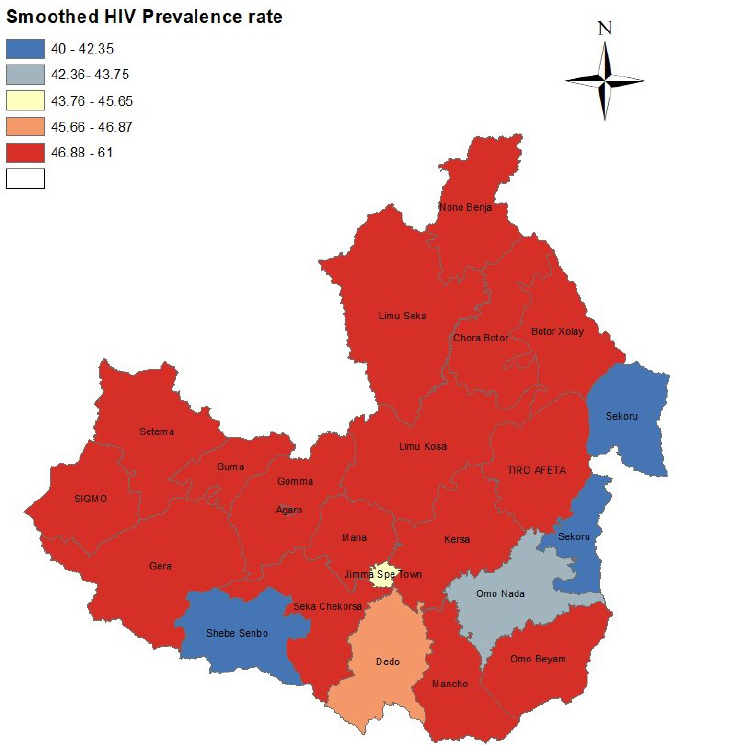
Figure 3. Geographical distribution of posterior means or smoothed HIV prevalence.